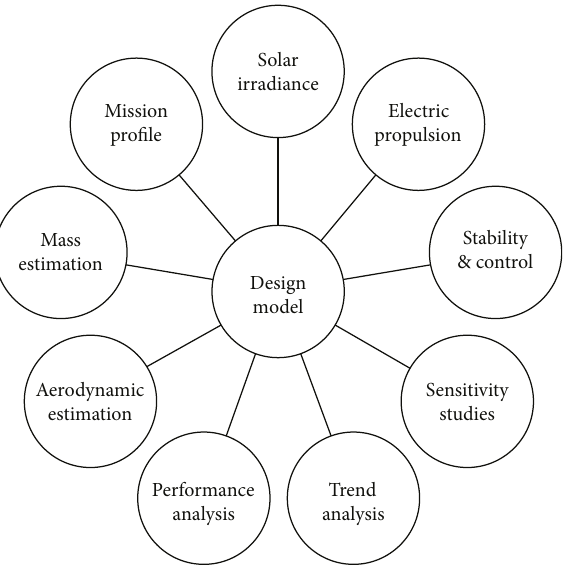
Figure 1: Solar-powered electric UAV design element.